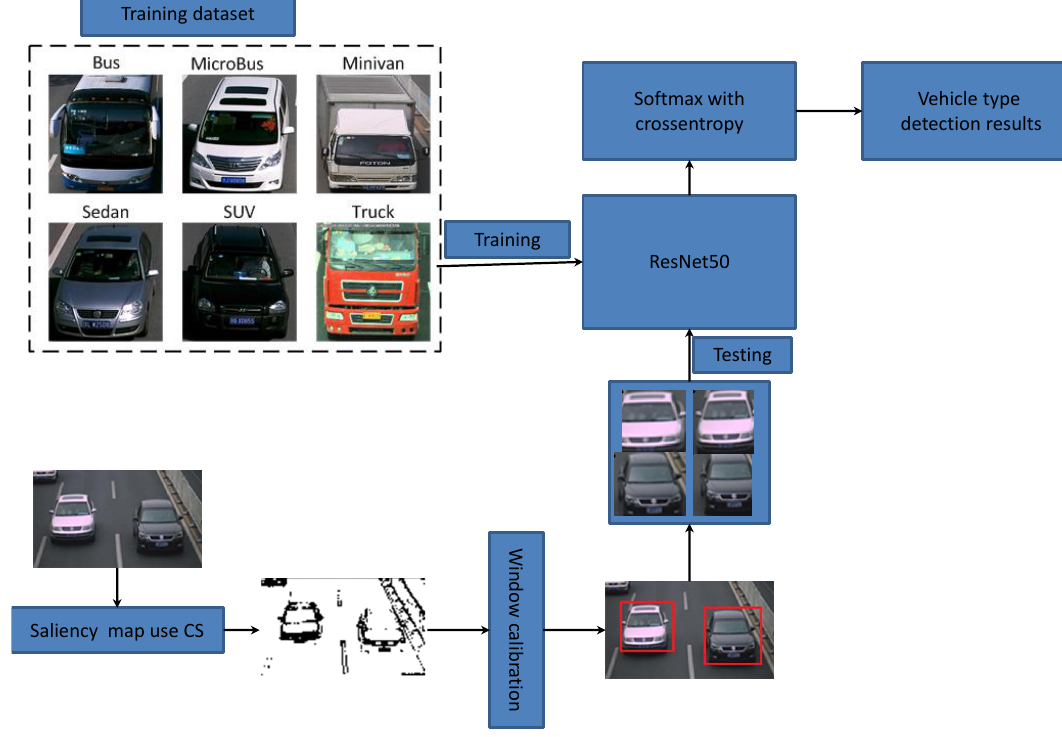
Figure 5. Diagram of vehicle-type detection based on CS and deep